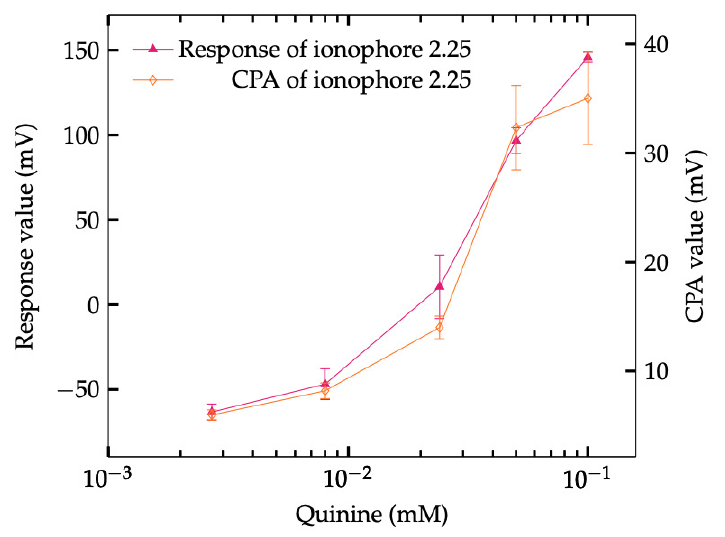
Figure 6. CPA Responses of NaISE of different Na + ionophore concentrations to Quinine + NaCl (70 mM)